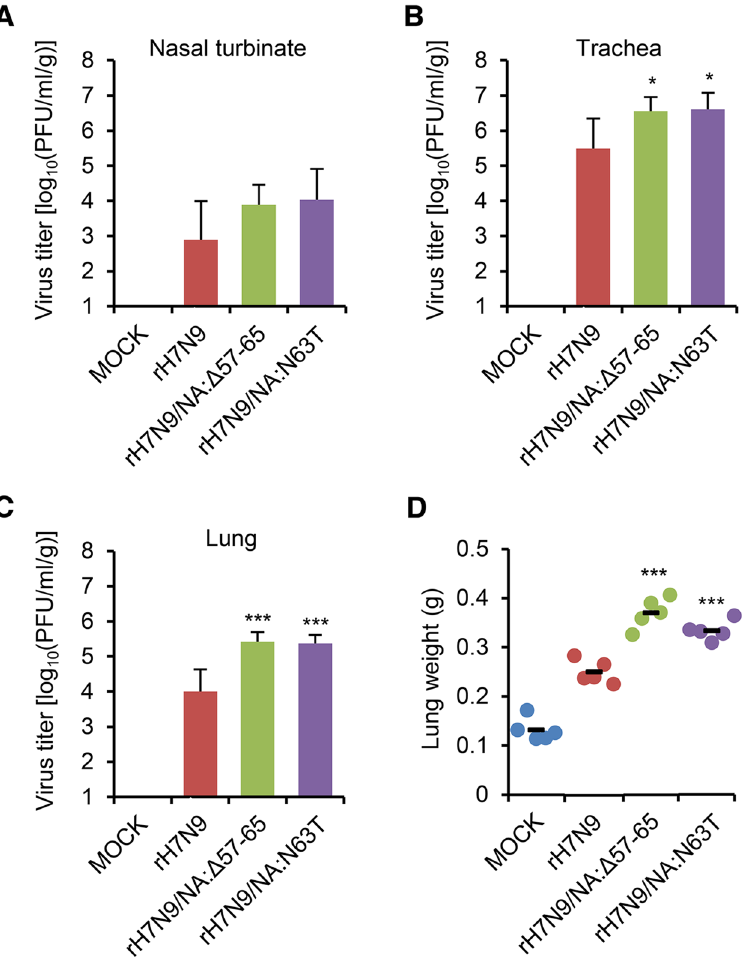
Figure 9. Pathogenicity of the H7N9 NA stalk mutant viruses in mice. Viral replication in the nasal turbinate ( A ), trachea ( B ), and lung ( C ) and lung weights ( D ) of the infected mice (n = 5) were investigated with 10 6 PFU intranasal infection. The results were represented in average, and error bars denote SD ( * P < 0.05 and *** P < 0.001 compared with the rH7N9